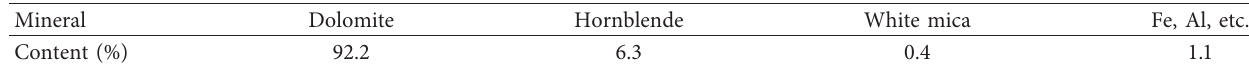
Table 2: Mineral composition of marble used in this study.